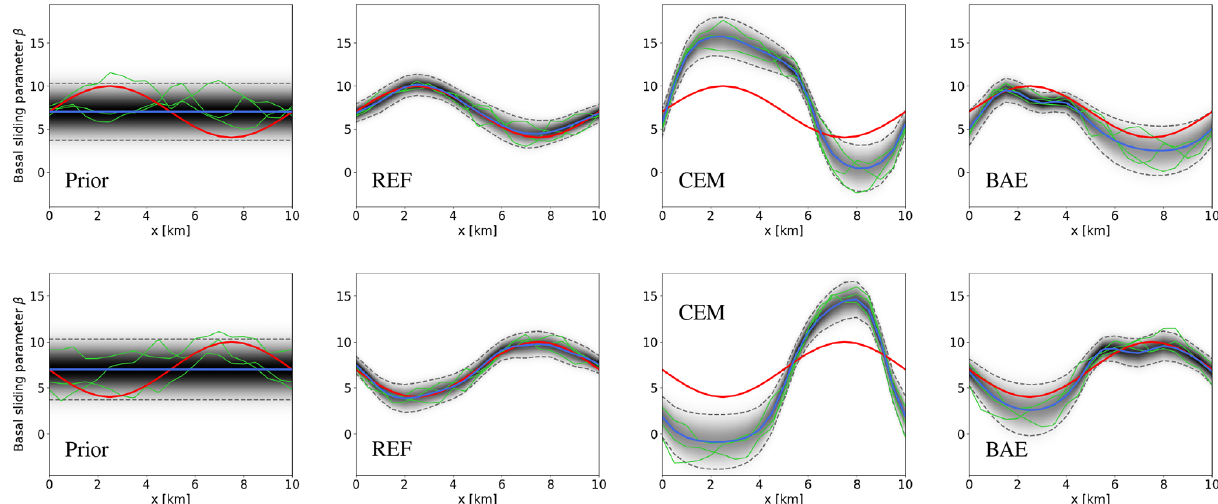
Figure 14. Cross sections of prior and MAP estimates of the basal sliding parameter for Example 3. Top row: cross section along line l 1 ( y = 2 . 5km) of prior (far left), accurate/reference (REF) case (center left), conventional error model (CEM) case (center right), and Bayesian approximation error (BAE) case (far right). The bottom row shows the cross section along line l 2 ( y = 7 . 5km) in the same order. In each plot, the mean of the distribution (blue line) is shown along with the true basal sliding parameter, β true (red line), three samples from the respective distributions (green lines), the marginal distribution (shaded) with darker shading indicating higher probability, and the ± 2 (approximate) standard deviation intervals (dashed black line).